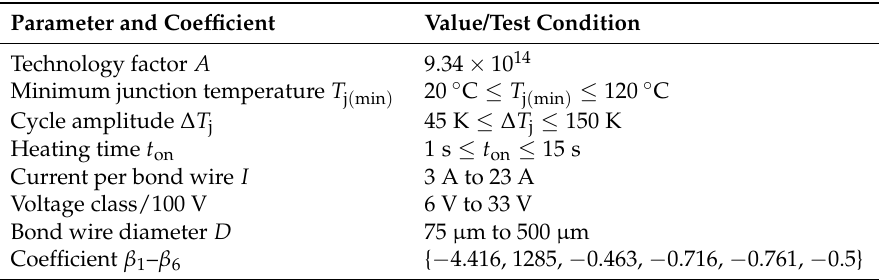
Table 3. Parameters and coefficient of the Bayerer Model